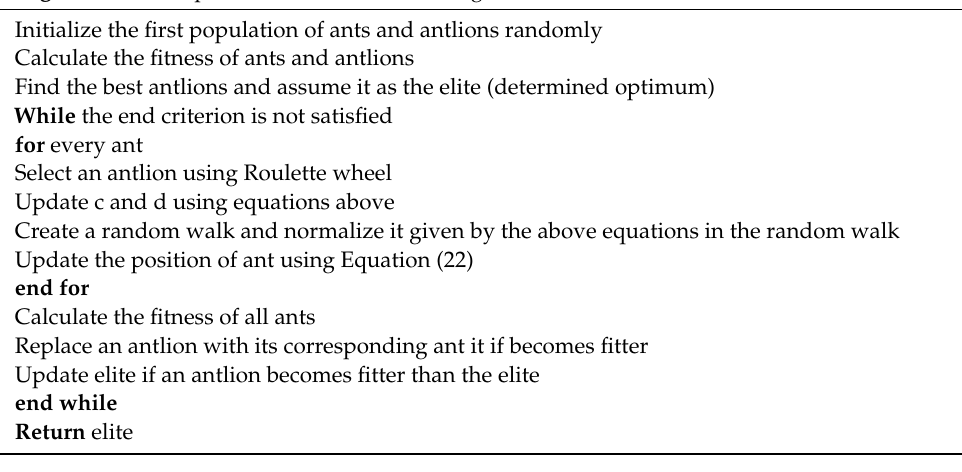
Algorithm 1. The pseudo-codes of the ALO algorithm